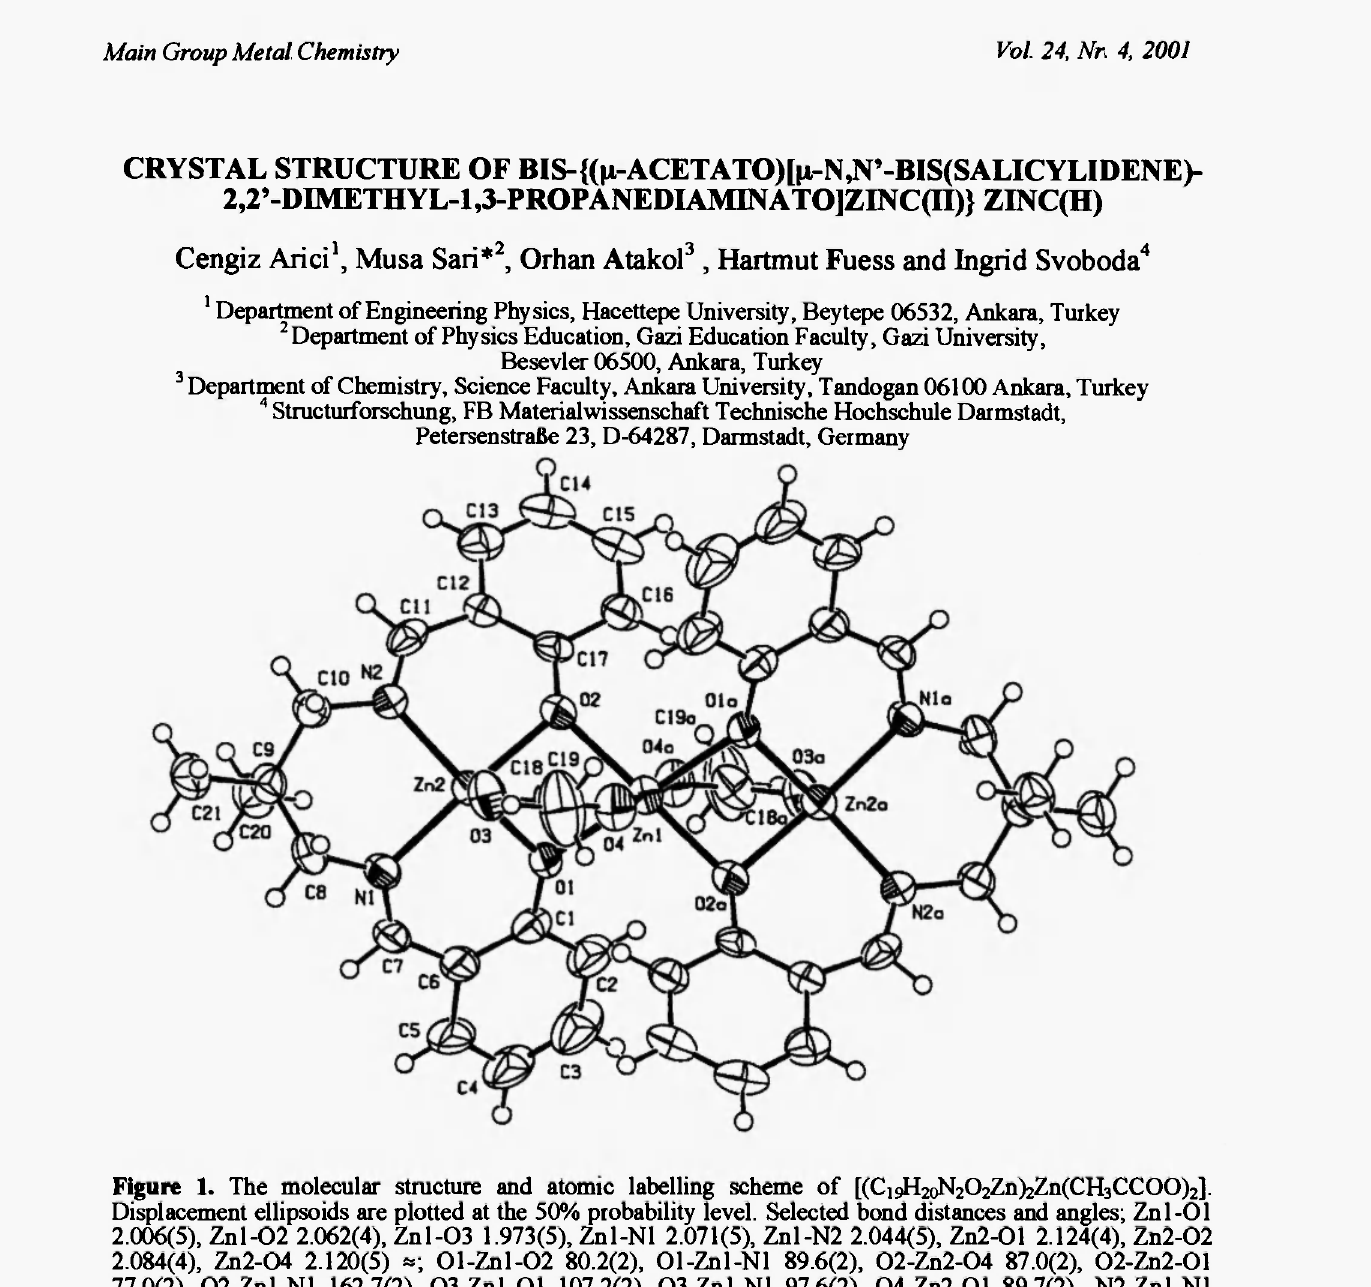
Figure 1. The molecular structure and atomic labelling scheme of [(C Displacement ellipsoids are plotted at the 50% probability level. Selected bond distances and angles; Znl-Ol 2.006(5), Znl-02 2.062(4), Znl-03 1.973(5), Znl-Nl 2.071(5), Znl-N2 2.044(5), Zn2-01 2.124(4), Zn2-02 2.084(4), Zn2-04 2.120(5) 01-Znl-02 80.2(2), Ol-Znl-Nl 89.6(2), 02-Zn2-04 87.0(2), 02-Zn2-01 77.0(2), 02-Znl-Nl 162.7(2), 03-Znl-01 107.2(2), 03-Znl-Nl 97.6(2), 04-Zn2-01 89.7(2) N2-Znl-Nl